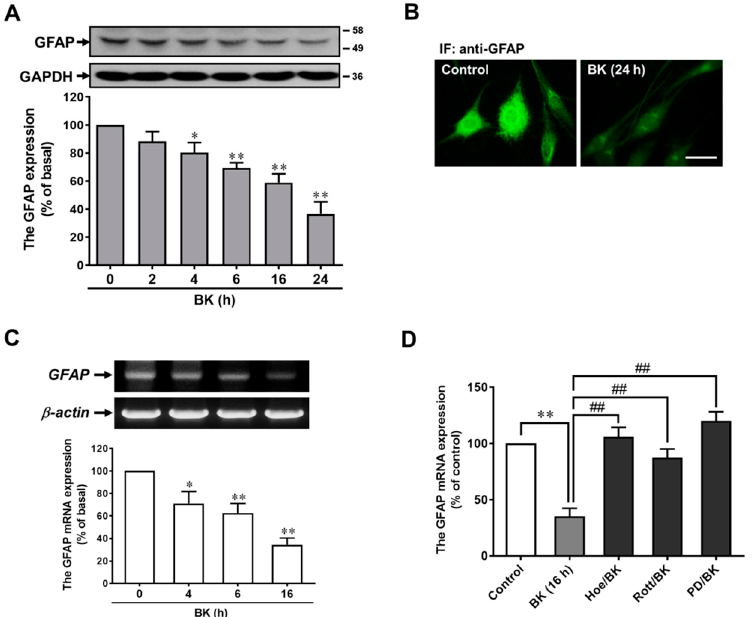
Figure 5. BK downregulates astrocytic marker GFAP expression in RBA cells. ( A ) Time dependence of BK-induced downregulation of GFAP protein expression. RBA cells were treated with 10 nM BK for the indicated times. The whole-cell lysates were analyzed by Western blot using an anti-GFAP or anti-GAPDH antibody. ( B ) The downregulation of GFAP by BK was confirmed by immunofluorescence in RBA cells. Cells were treated without (control) or with BK (10 nM) for 24 h and then labeled using an anti-GFAP antibody and a FITC-conjugated secondary antibody. Individual cells were imaged (scale bar = 20 µ m) as described in “Methods”. ( C ) Time dependence of BK-downregulated GFAP mRNA expression. RBA cells were treated with 10 nM BK for the indicated times. ( D ) Cells were pretreated with Hoe140 (Hoe, 10 µ M), rottlerin (Rott, 1 µ M), PD98059 (PD, 10 µ M) for 1 h and then incubated with BK (10 nM) for 16 h. The total RNA was extracted and analyzed by RT-PCR as described under “Methods”. Data are expressed as the mean ± SEM of at least three independent experiments. * p < 0.05, ** p < 0.01, as compared with control. ## p < 0.01, as compared with BK alone. The image represents one of at least three individual